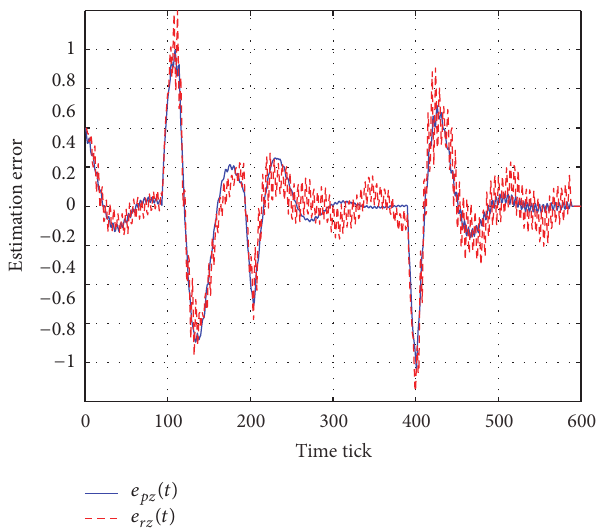
Figure 4: Estimation errors for the proposed method and round robin with ZOH.